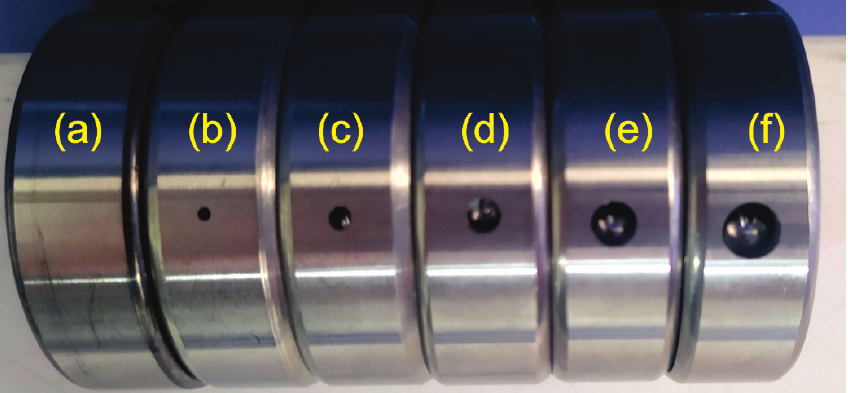
Figure 6. Bearings used throughout the experiments: ( a ) healthy bearing. ( b ) 1 mm hole diameter failure. ( c ) 2 mm hole diameter failure. ( d ) 3 mm hole diameter failure. ( e ) 4 hole mm diameter failure. ( f ) 5 mm hole diameter